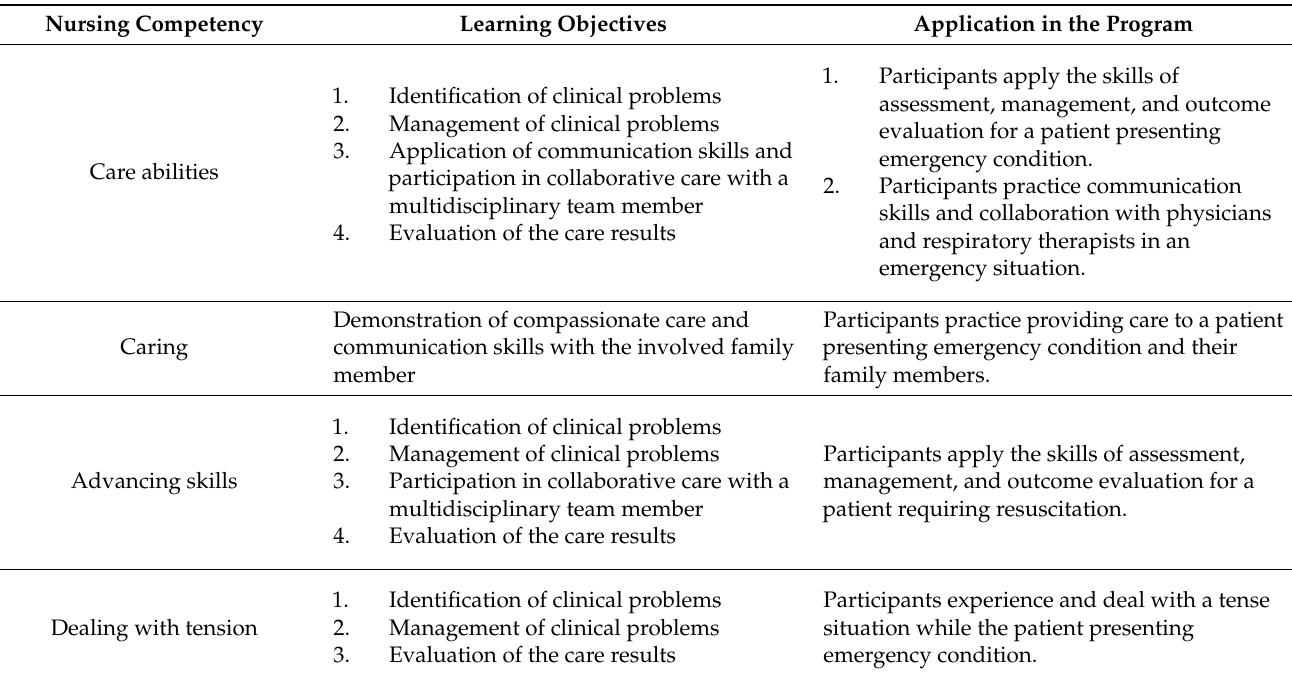
Table 1. Rationale of the interprofessional simulation